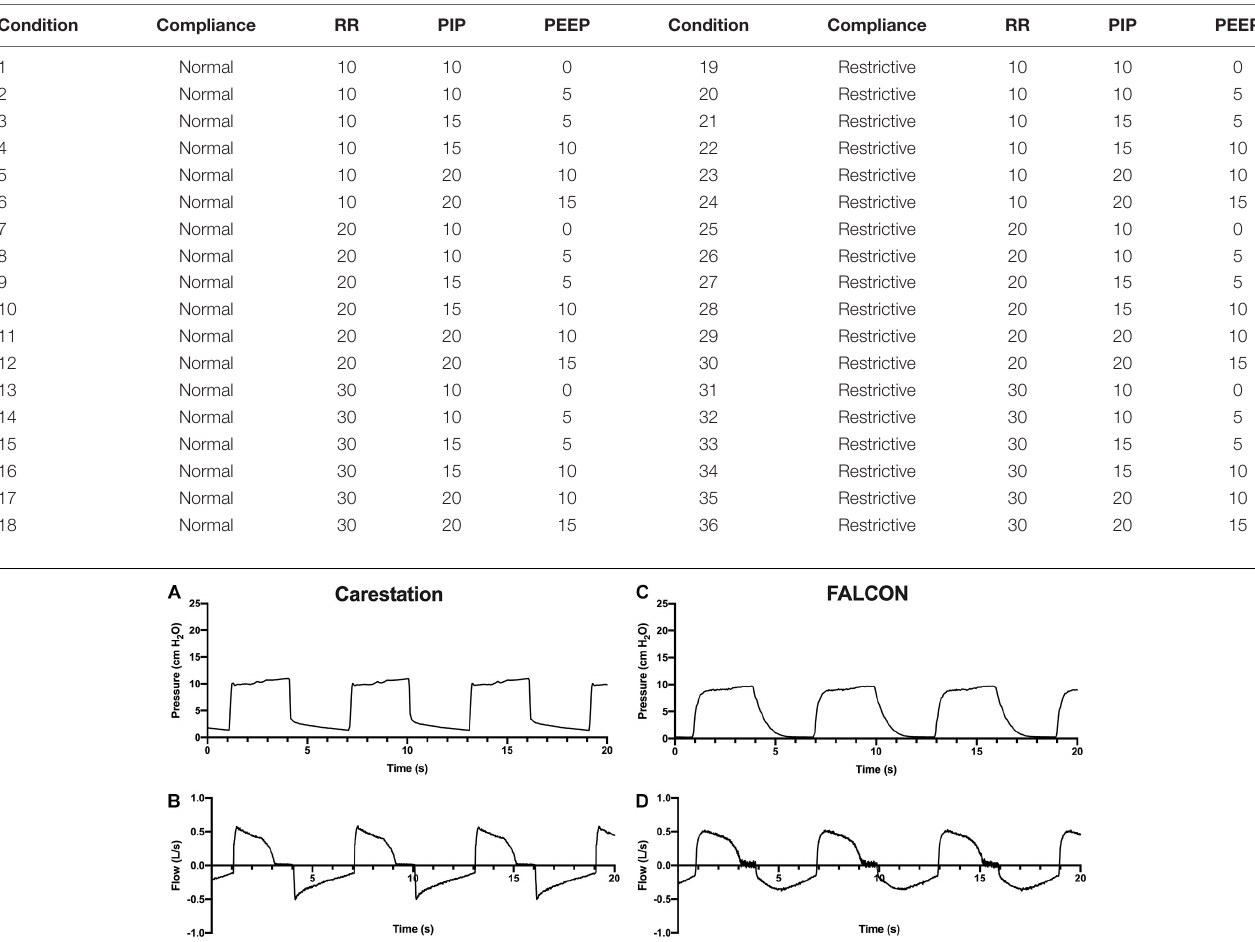
FIGURE 4 | Pressure (in cm H 2 O) and flow (in L/s) curves generated by the CarestationTM (A,B) and FALCON prototype (C,D) ventilators over a 20 s period during test condition 1 (peak inspiratory pressure = 10 cm H 2 O, positive end expiratory pressure = 0 cm H 2 O, respiratory rate = 10 breaths per min, and normal lung compliance of 74 mL/cm H 2 O). The remaining pressure and flow curves can be seen in Supplementary Figure 1